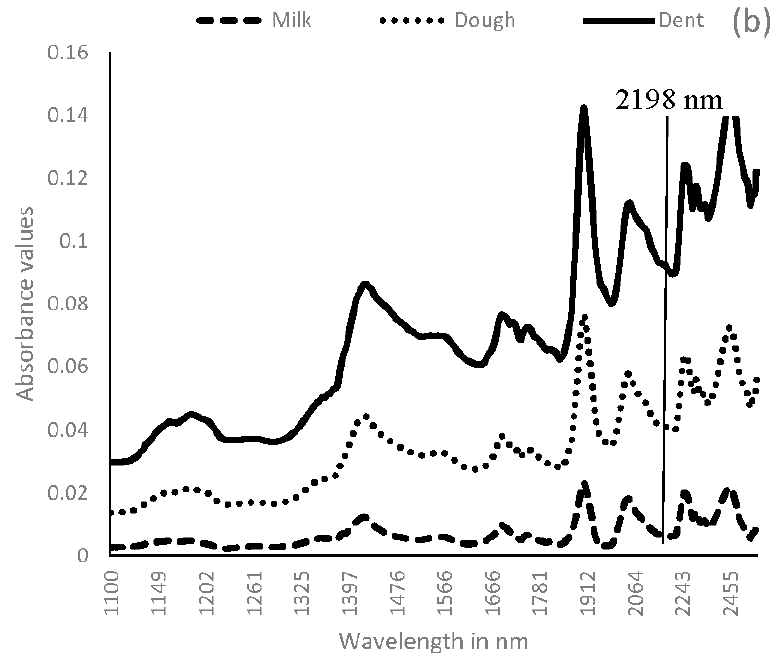
Figure 1. ( a ) Near infrared (NIR) spectral pattern of uninoculated maize kernels from 1100–2600 nm; ( b ) 1100 nm–2600 nm after spectral treatment by first derivative Savitzky-Golay (1d-SG) + multiplicative scatter correction (MSC).